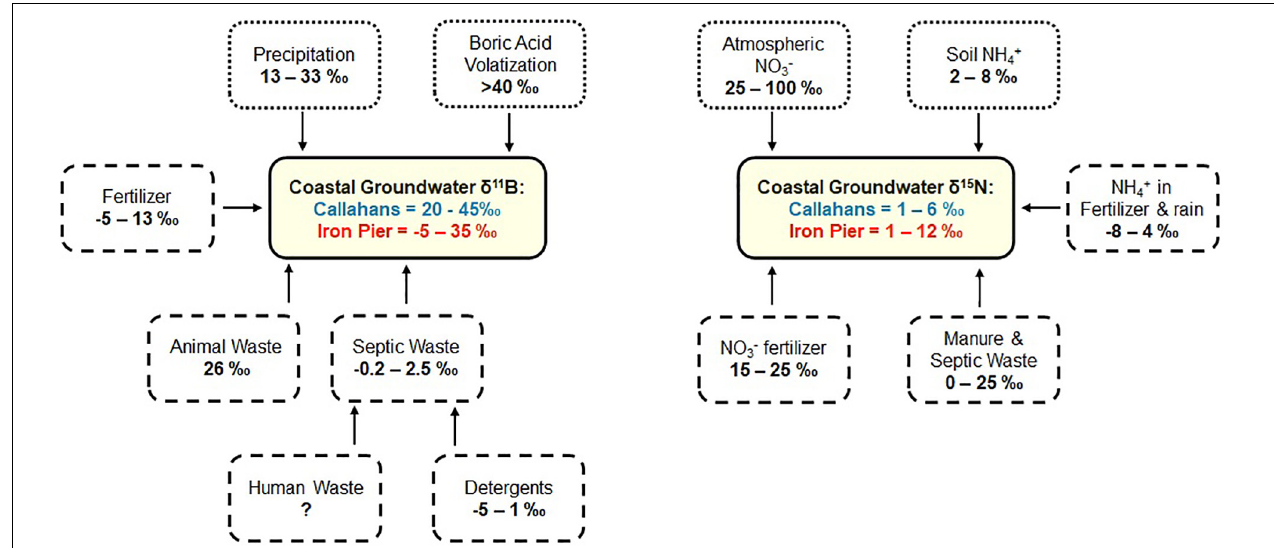
FIGURE 7 | Summary of δ 11 B (left) and δ 15 N (right) endmember isotope ratios of coastal groundwaters. Dotted boxes reflect natural sources or processes. Dashed boxes reflect anthropogenic contaminant sources. δ 11 B ratios constrained from Tables 1 , 2 . δ 15 N ratios from Kendall et al.